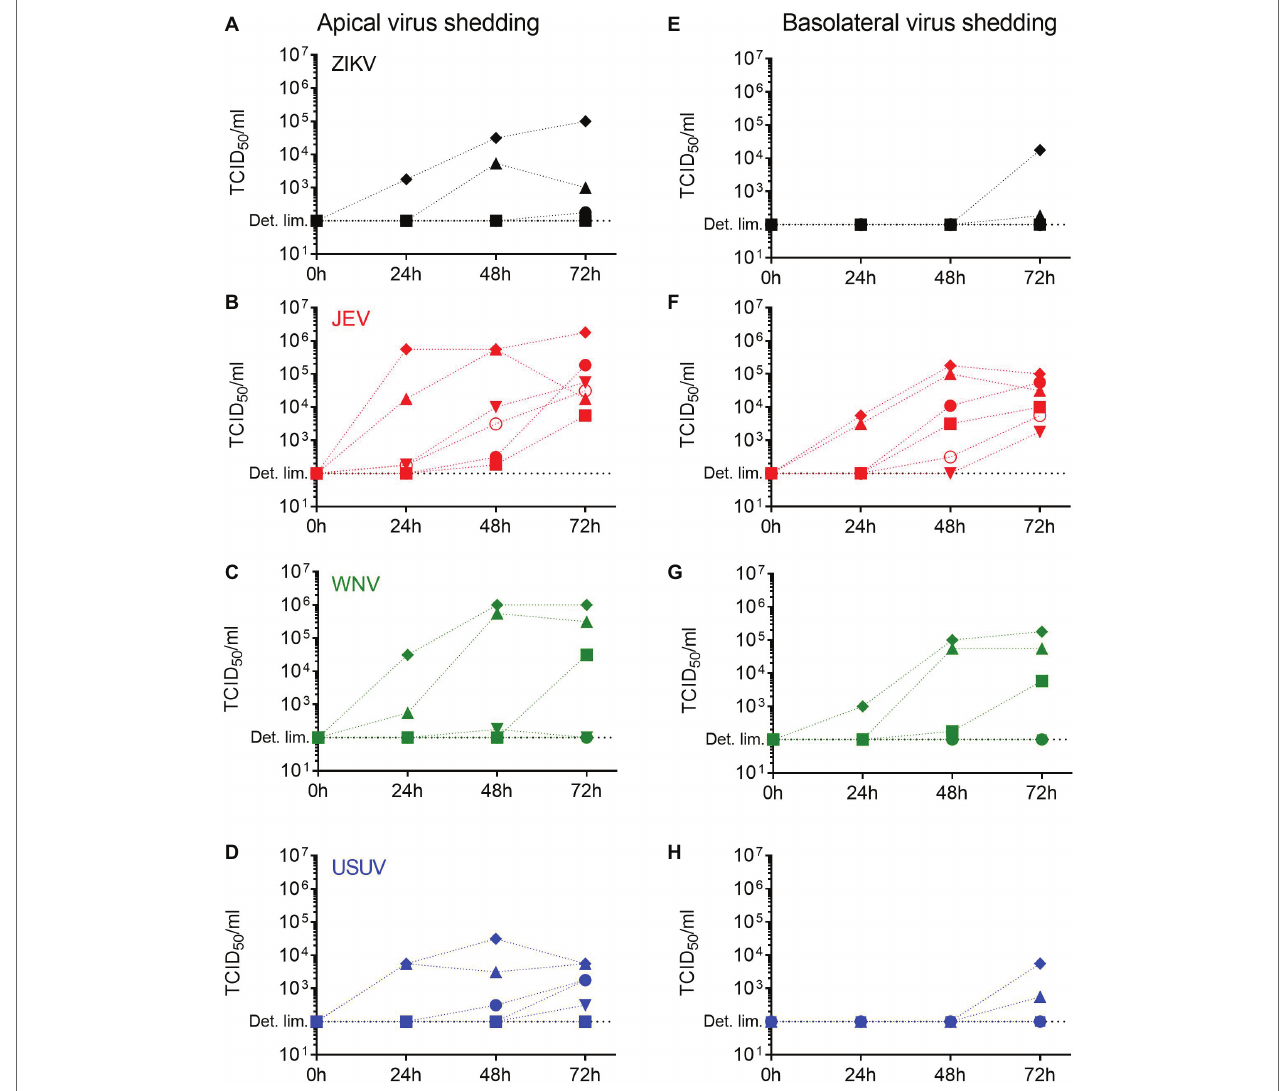
FIGURE 2 | Release of infectious virus by flavivirus-infected human NECs. Apical and basolateral virus shedding up to 72 h p.i. with ZIKV (A,E) , JEV (B,F) , WNV (C,G) , and USUV (D,H) measured by TCID 50 assay in NECs infected at a MOI of 1 TCID 50 /cell. Each symbol represents an independent donor (donor I: dot, donor II: square, donor III: upward triangle, donor IV: diamond, donor V: circle, and donor VI: downward